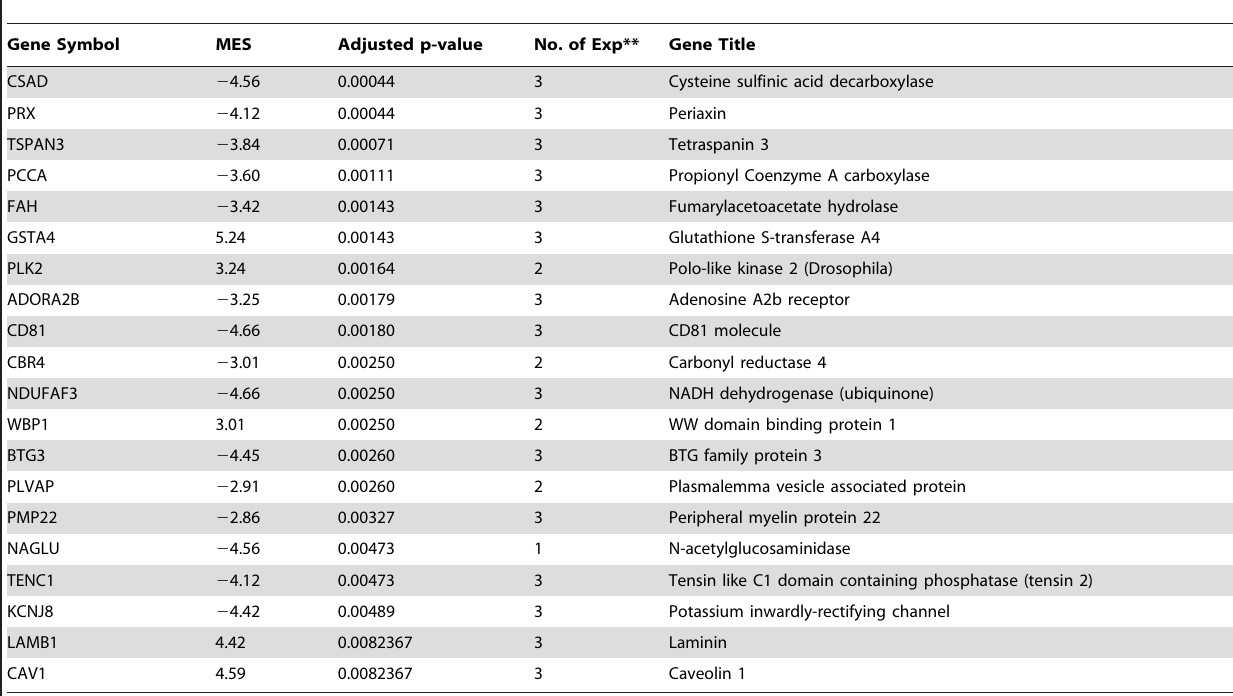
Table 4. Top 20 genes identified by the microarray meta-analysis as differentially expressed in two-hit model of VILI.